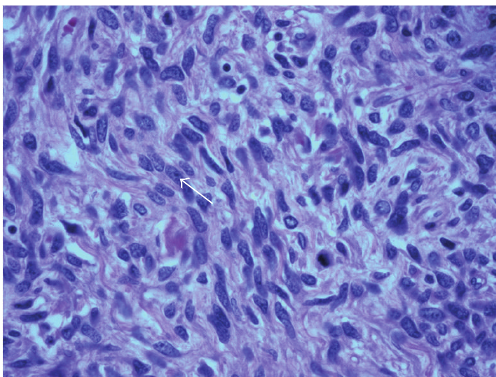
Figure 3: High-power field histopathology shows well-preserved tumor with mitotic figures